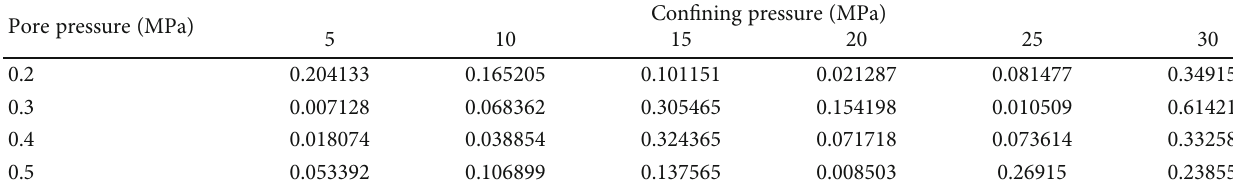
Table 7: Contribution rates of the gas slippage e ff ects (700 °